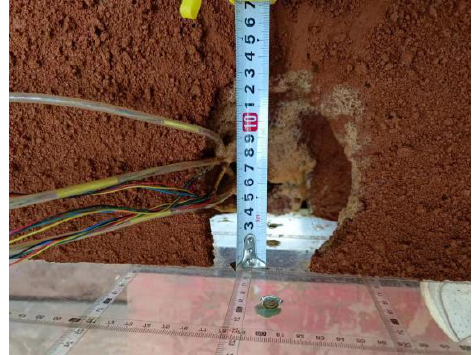
Figure 14. Surface collapse map.